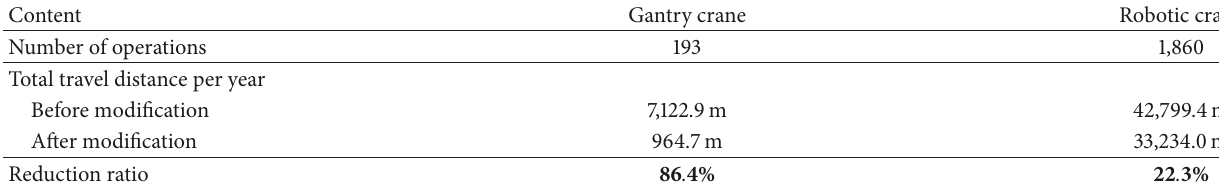
Table 7: Effect of layout modification for the operation of crane systems at the target facility.